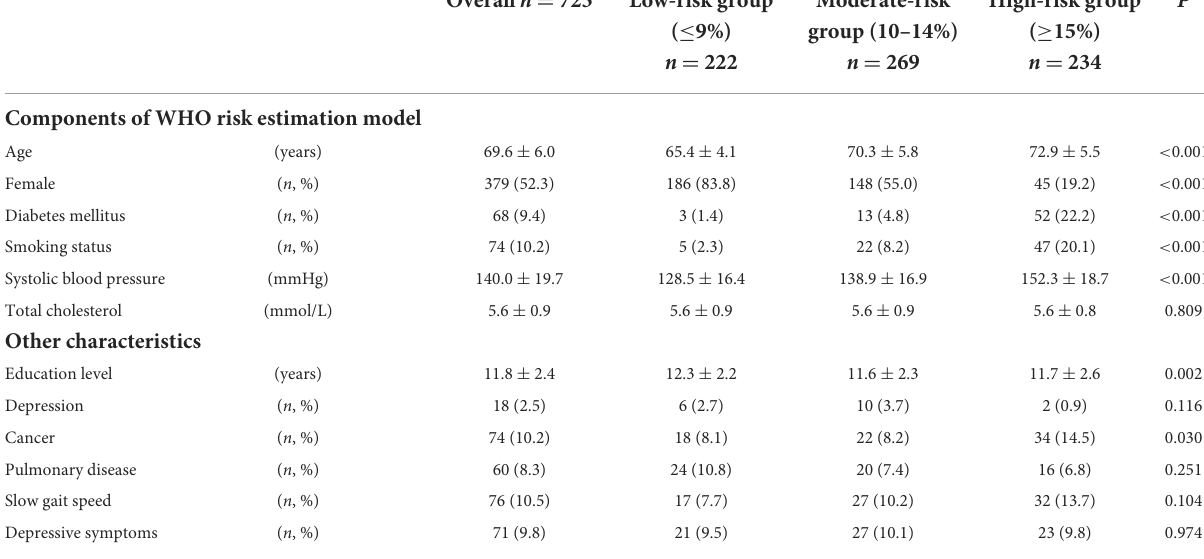
TABLE 1 Participant characteristics according to estimated cardiovascular risk levels.